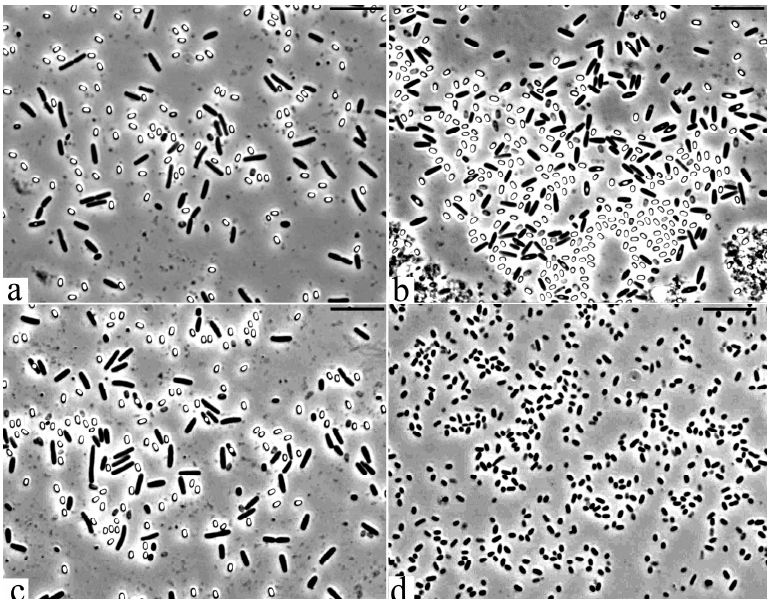
Figure 3. Cells of the studied strains in the exponential growth phase. ( a ) Bacillus subtilis 27, ( b ) Bacillus subtilis 28, ( c ) Bacillus subtilis 18 and ( d ) Pseudomonas chlororaphis 3. Light microscopy. Phase contrast. Bar—10 µm.